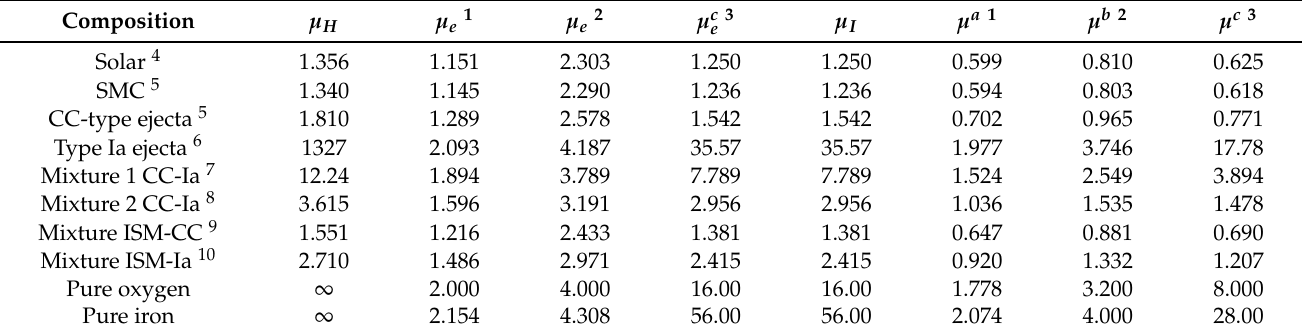
Table 1. Summary of Mean Molecular Weights.